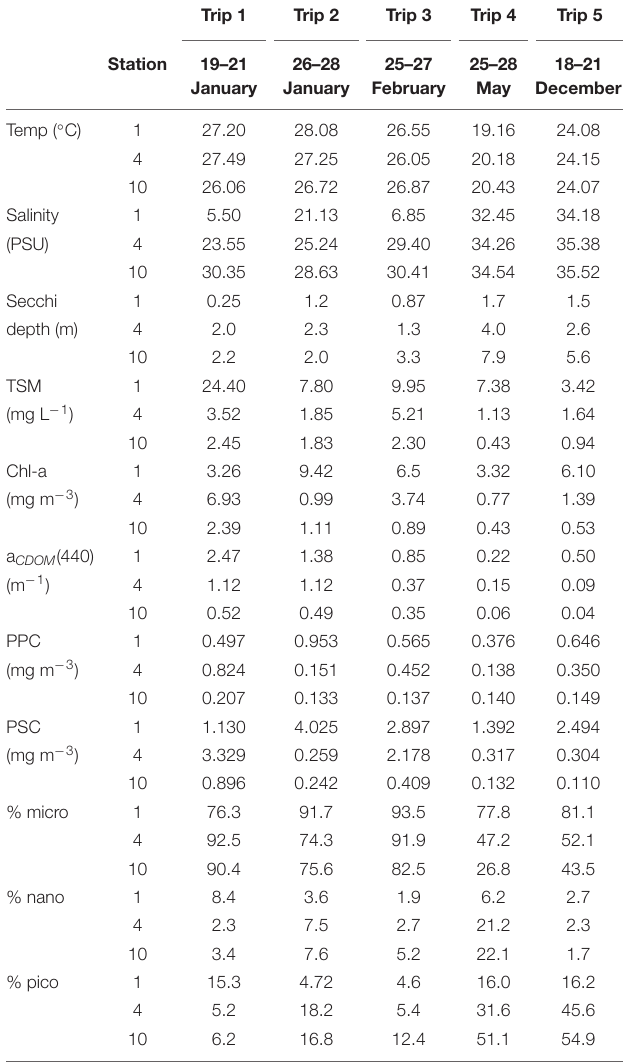
TABLE 1 | Values of environmental parameters from surface water samples collected from three stations within Moreton Bay, I, 2, 6, 19, and 48-weeks post